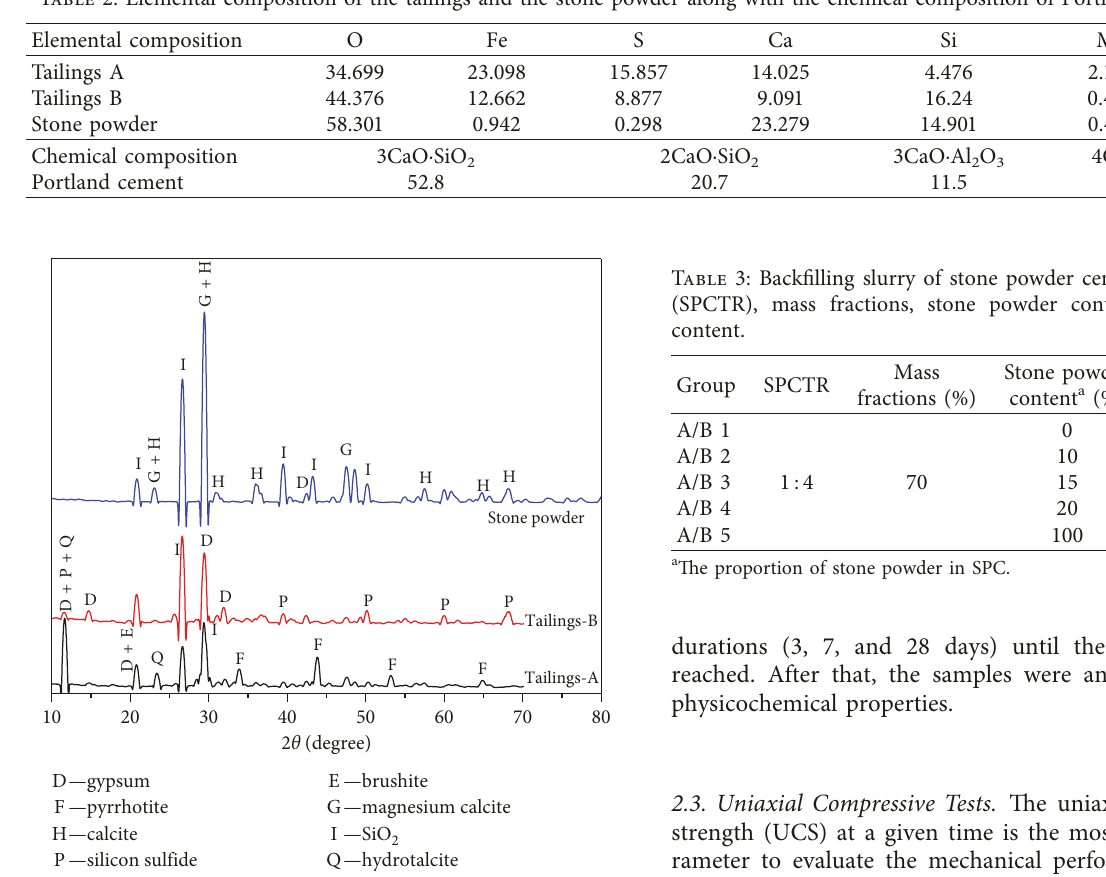
Figure 4: XRD patterns of the tailings and stone powder.